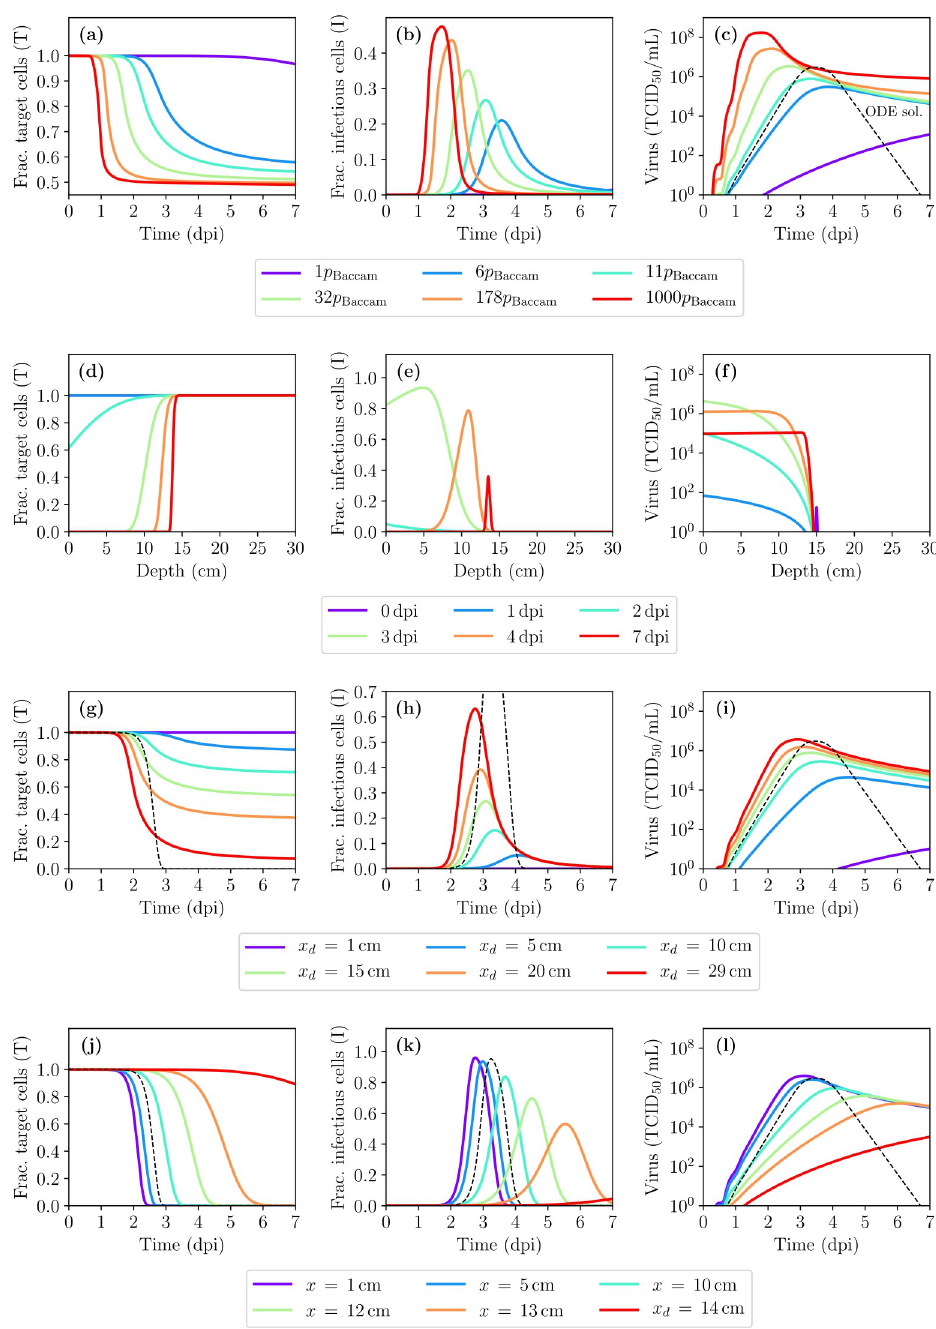
Fig 3. IAV infection kinetics in the presence of diffusion and advection. (a,b,c) Time course (averaged over space) of the infection for the fraction of cells in the (a) target/uninfected or (b) infectious state, and (c) the infectious virus concentration, obtained using the ODE MM (dashed) or the spatial MM (solid), as the rate of virus production, p , is varied. (d,e,f) Localized fraction of cells in the (d) target or (e) infectious state and (f) the infectious virus concentration as a function of depth within the HRT shown at specific days post-infection (dpi). (g,h,i) Same as (a,b,c) but varying the depth of deposition of the initial virus inoculum ( x ). (j,k,l) Similar to (a,b,c) but rather than being averaged over d space, the infection time course is shown at specific, spatially localized depths ( x ). Unless otherwise noted, p = 11 × p Baccam and x d = 15